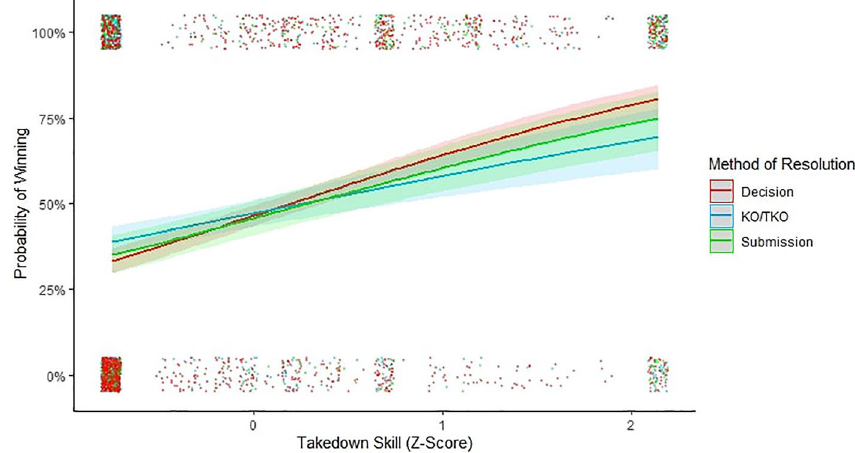
Figure 3. The interaction between grappling skill and method of resolution on the likelihood of winning (decision, KO/KTO, and submission). Error bands illustrate 95% confidence intervals. Data points are jittered for visibility purposes.